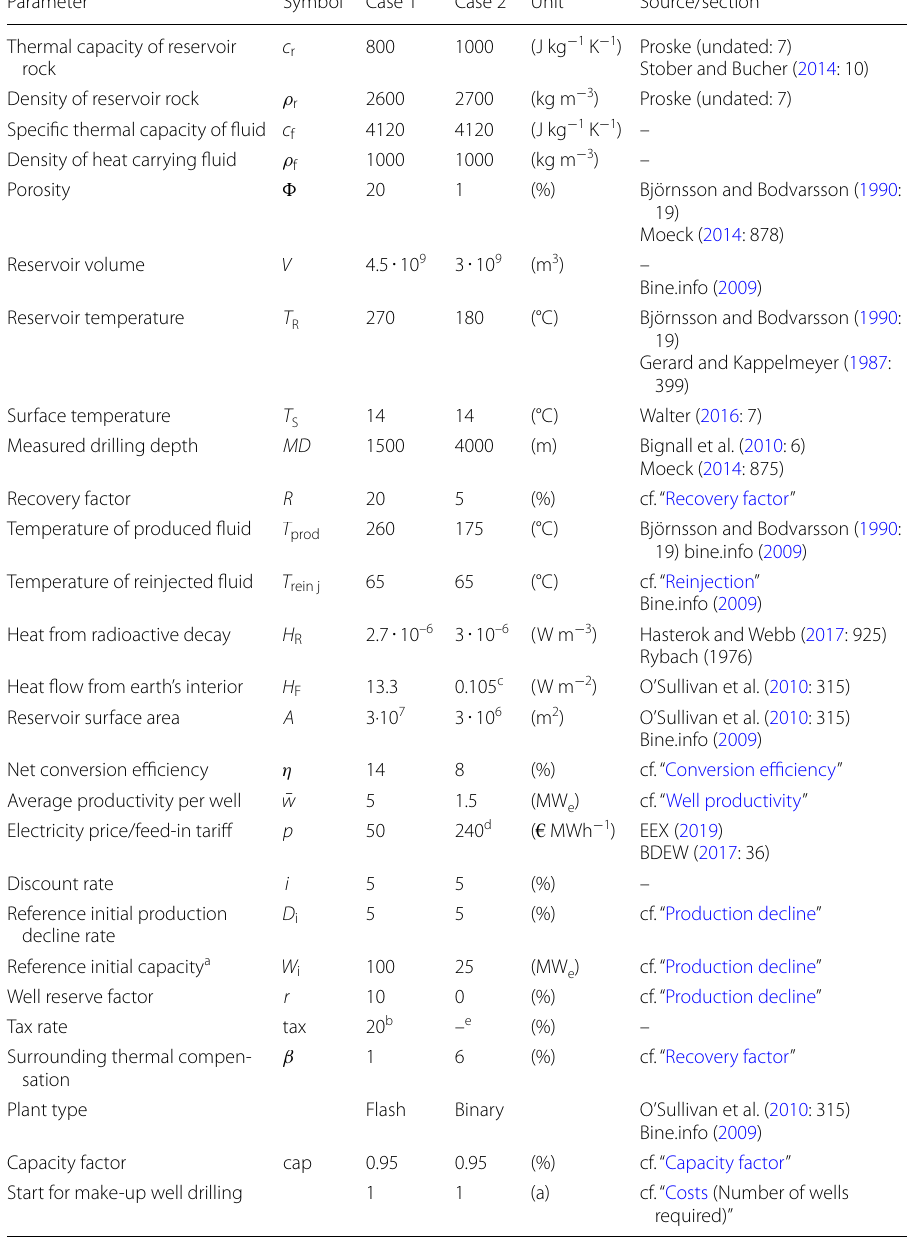
Table 3 Parametrization for Case 1 (conventional geothermal system) and Case 2 (enhanced geothermal